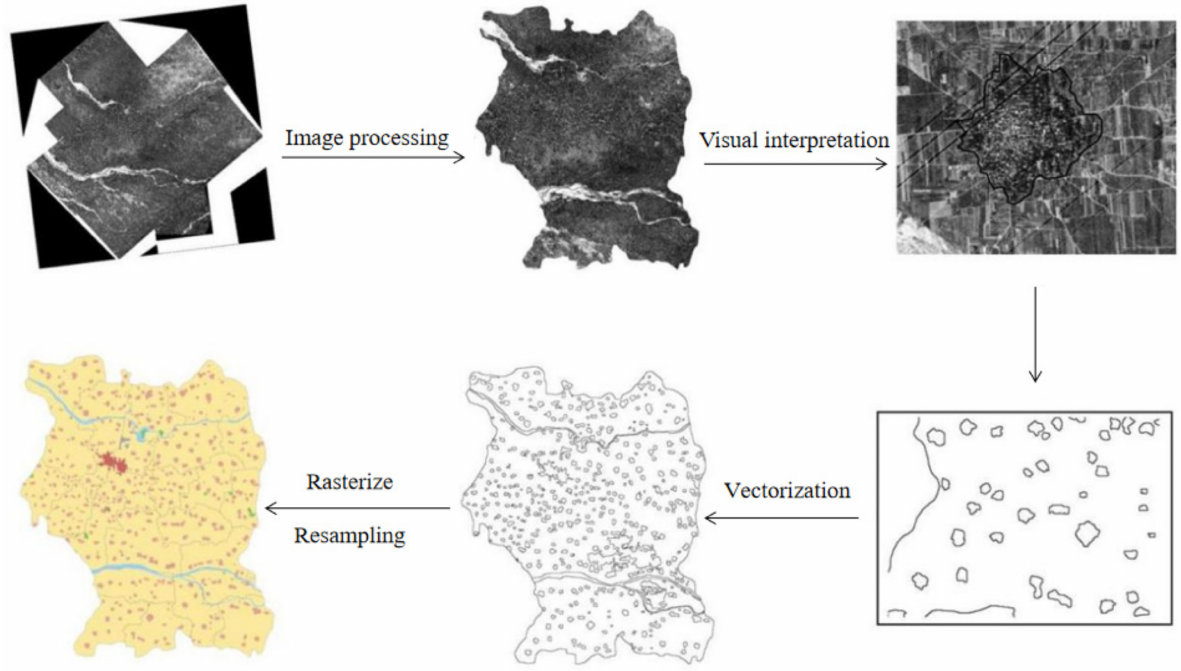
Figure 3. Visual interpretation